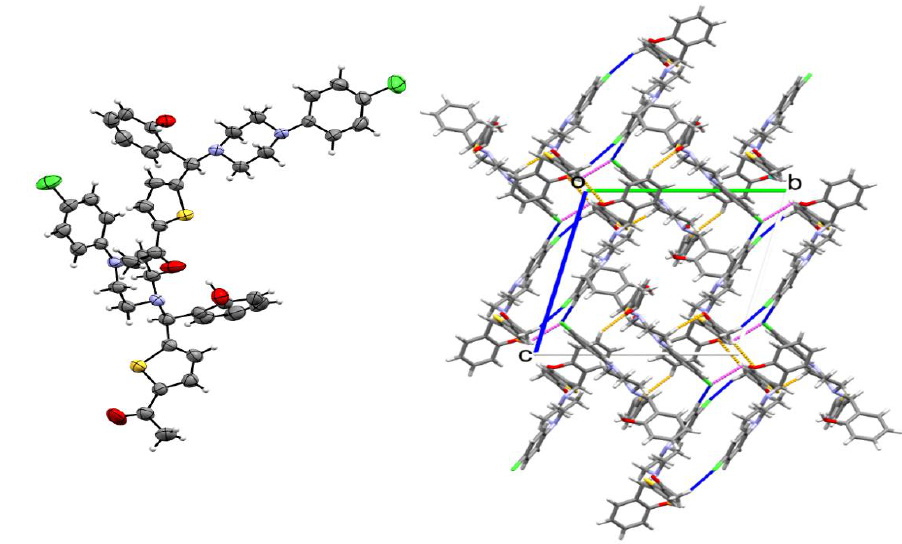
Figure 2. a ) ORTEP structure of compound 4r. Crystal packing viewed down a axis, showing